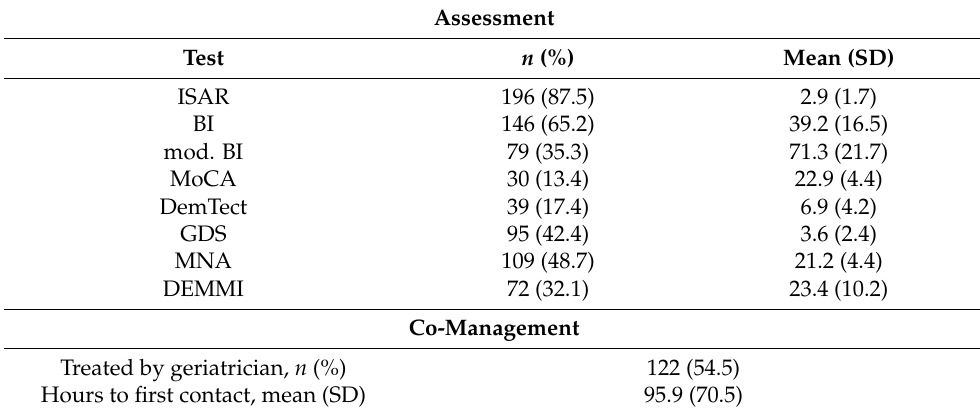
Table 2. Geriatric assessment and